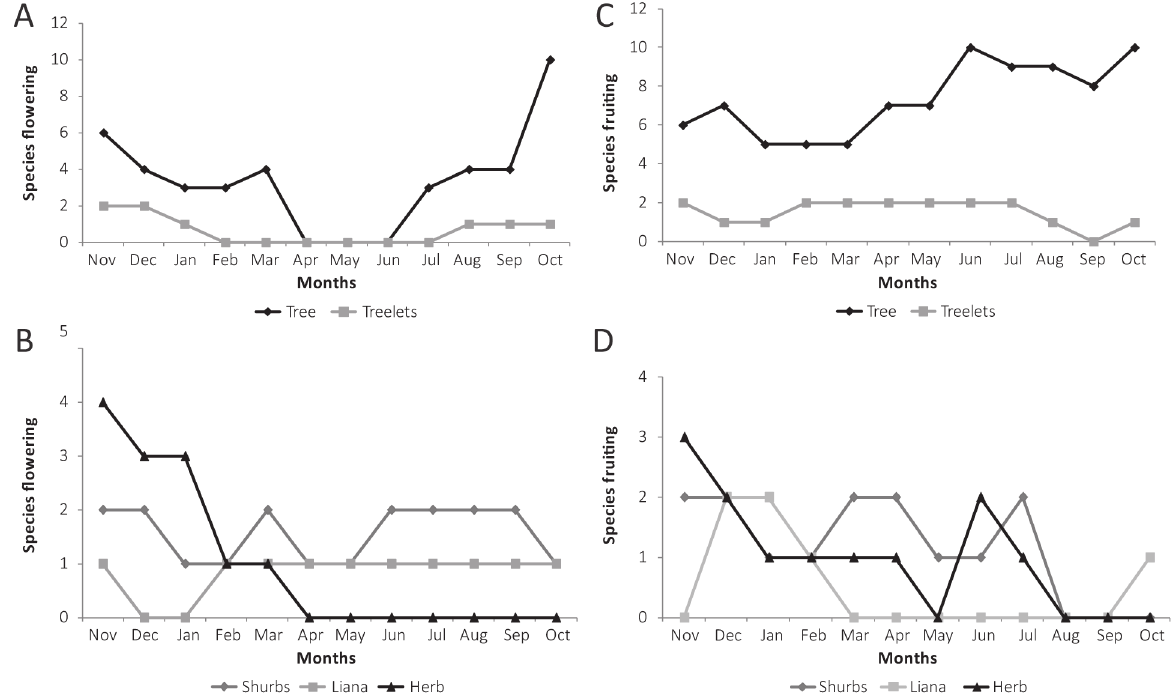
Fig. 3 - Number of flowering (A, B) and fruiting (C, D) species per month during the study year and their relation to